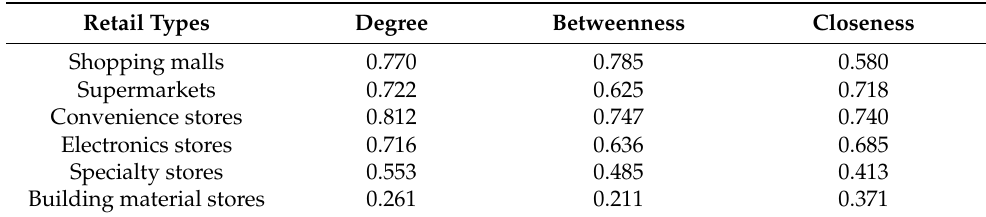
Figure 7. Spatial distributions of weighted degree centrality indices on weekends: ( a ) degree, 7:00–9:00; ( b ) degree, 11:00–13:00; ( c ) degree, 19:00–21:00; ( d ) betweenness, 7:00–9:00; ( e ) betweenness, 11:00–13:00; ( f ) betweenness, 19:00–21:00; ( g ) closeness, 7:00–9:00; ( h ) closeness, 11:00–13:00; ( i ) closeness, 19:00–21:00. Table 3. Correlation coefficients of KDE values of stores and weighted centrality indices of total flow